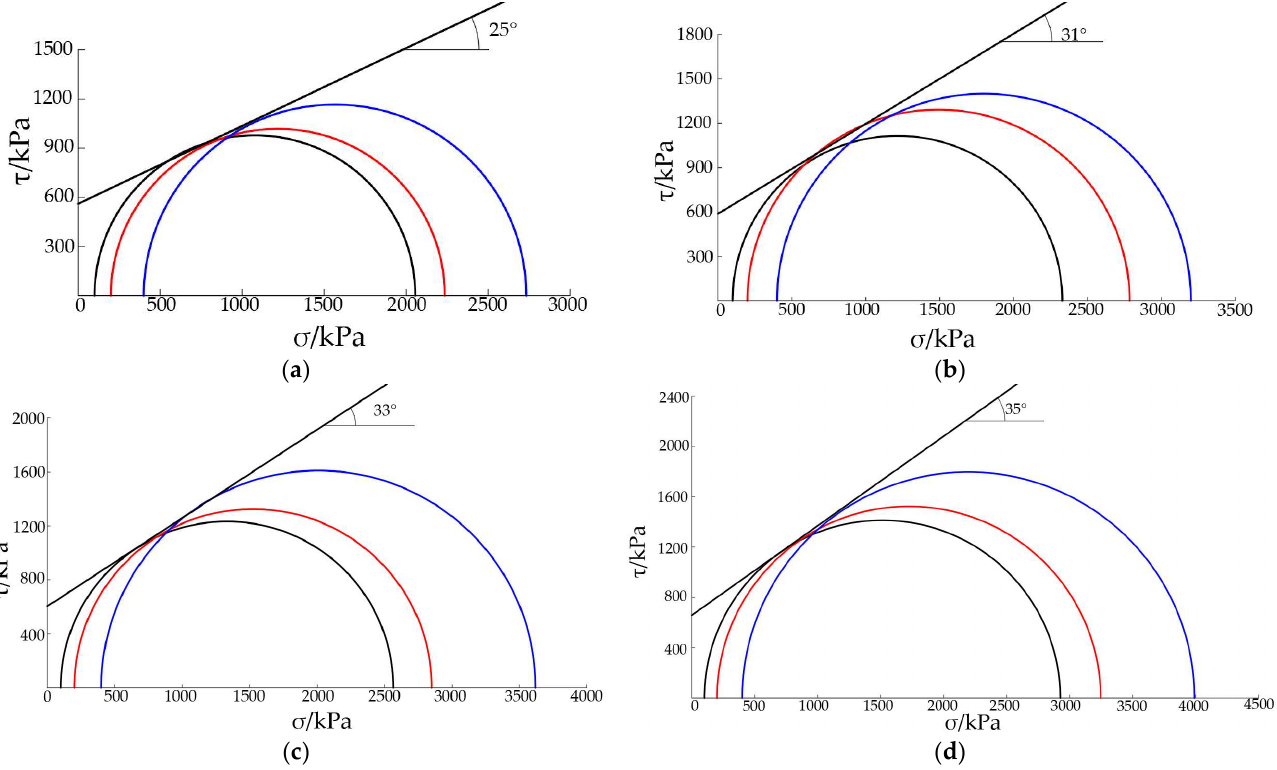
Figure 6. Molar circle and strength envelope of fiber cement soil with different fiber content. ( a ) fiber content 0%; ( b ) fiber content 0.1%; ( c ) fiber content 0.2%; ( d ) fiber content 0.4%. Note: the black contour line represents the confining pressure of 100 kPa, the red contour line represents the confining pressure of 200 kPa, and the blue contour line represents the confining pressure of 400 kPa.